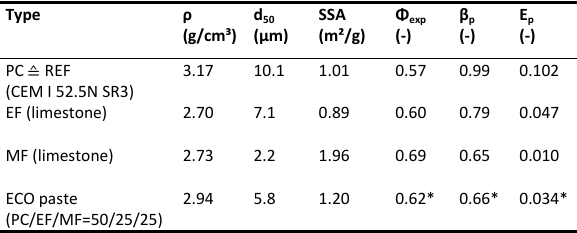
Table 1. Properties of granular source materials and of optimized PC/EF/MF mix